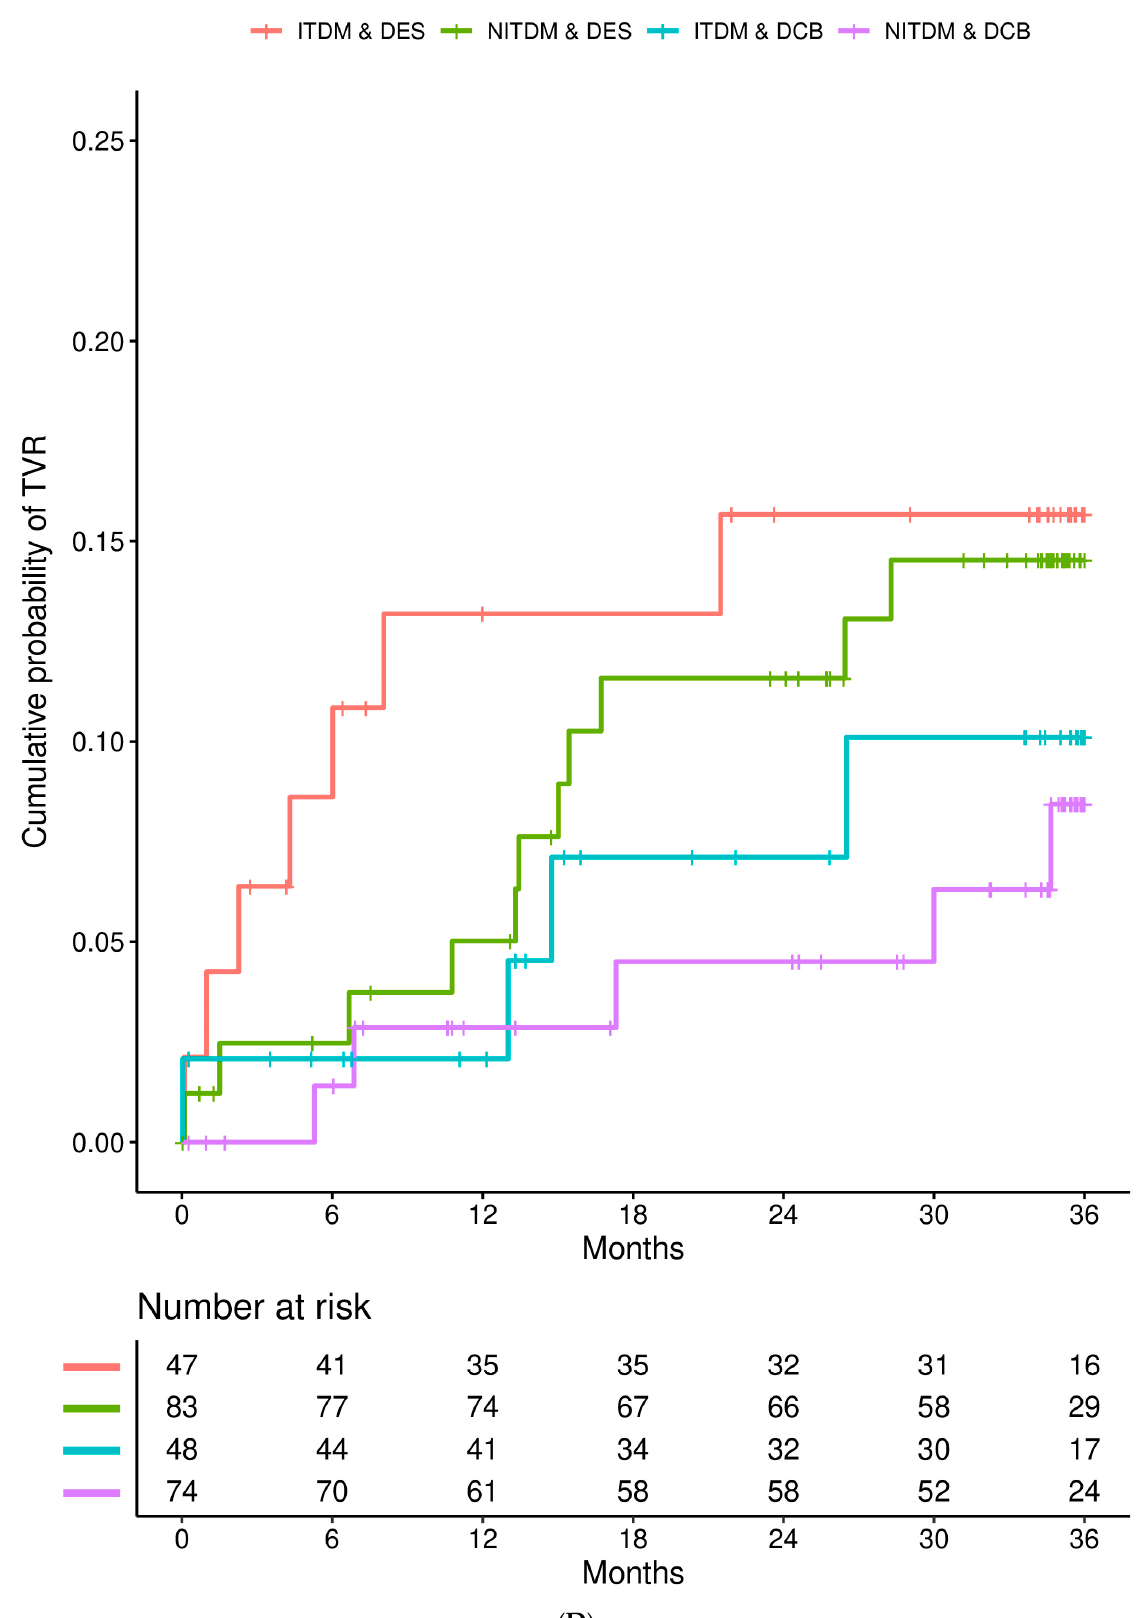
Figure 1. Interaction is presented for diabetes mellitus and randomized treatment strategy. ( A ) Kaplan–Meier estimates of the cumulative probabilities of major adverse cardiac events (MACE)